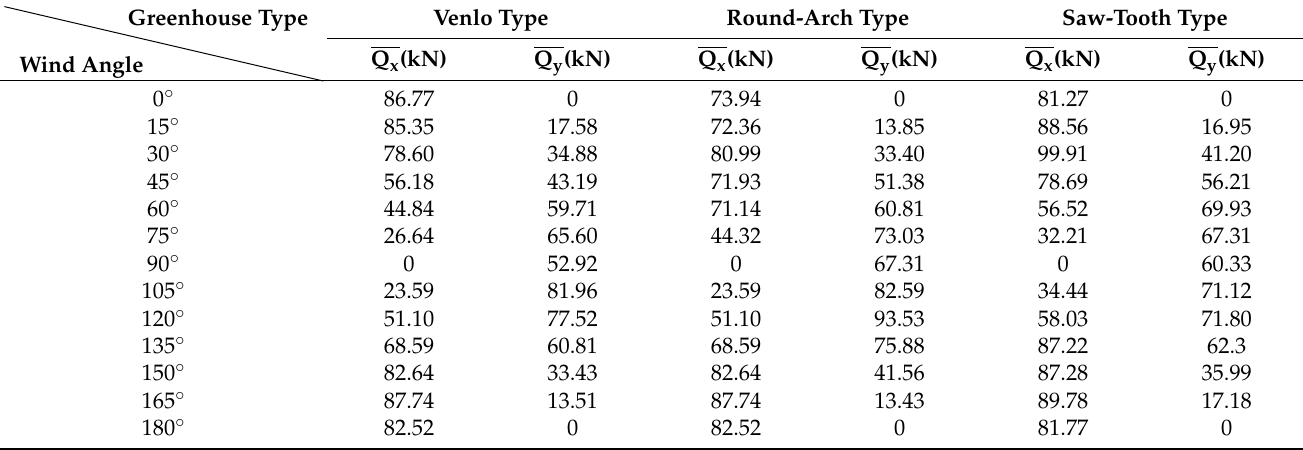
Table 7. Design wind load of main structure.